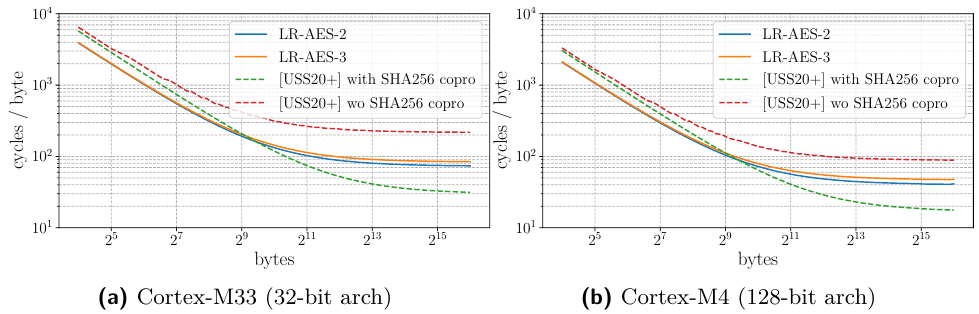
Figure 14: Performances of LR-AES modes -O3 -flto optimizations and n b =